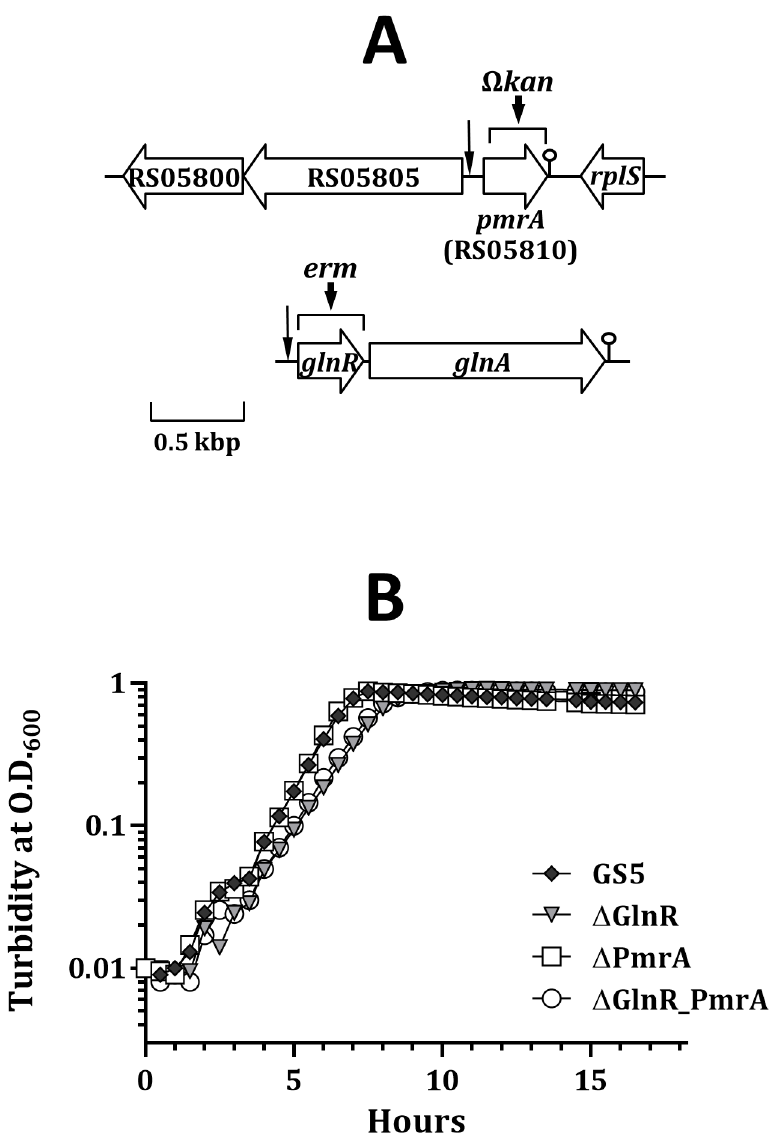
Fig 1. Schematic diagram of S . mutans GS5 SMUGS5_RS05810 ( pmrA ) and glnRA , and the growth kinetics of GS5 and its derivatives. (A) The relative locations of the predicated GlnR box in the 5 ’ flanking region of pmrA and glnR are indicated by a vertical arrow. The putative terminators of pmrA and glnRA are indicated by a lollypop-shaped symbol. The regions within pmrA and glnR that are replaced by Ω kan in strain Δ PmrA and erm in strain Δ GlnR, respectively, are indicated by a horizontal bracket. (B) The growth kinetics of wild-type S . mutans GS5, Δ GlnR, Δ PmrA, and the double knockout strain ( Δ GlnR_PmrA) in BHI are shown. A representative graph of at least three experiments is